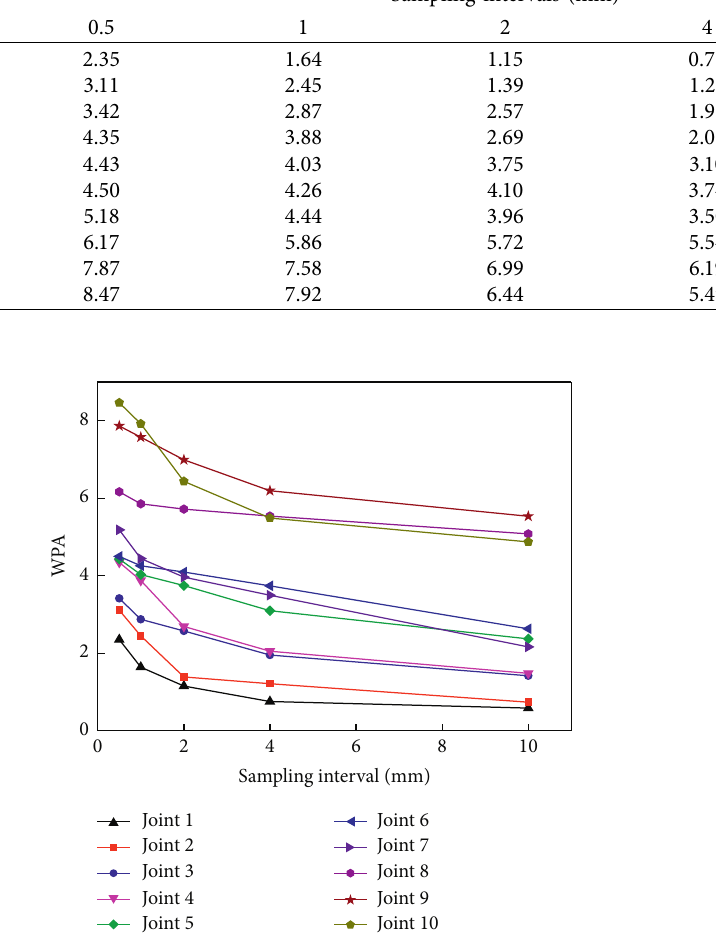
Figure 8: The effect of different sampling intervals on WPA values of 10 standard roughness joint